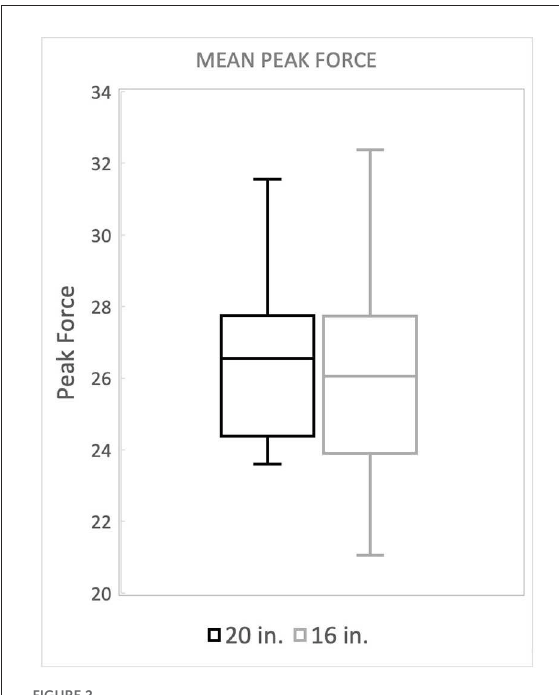
FIGURE2 Mean peak force when averaging the forelimbs. There was no significant difference between the standard (20 ′′ ) or preferred (16 ′′ ) height for mean peak force of the forelimbs.